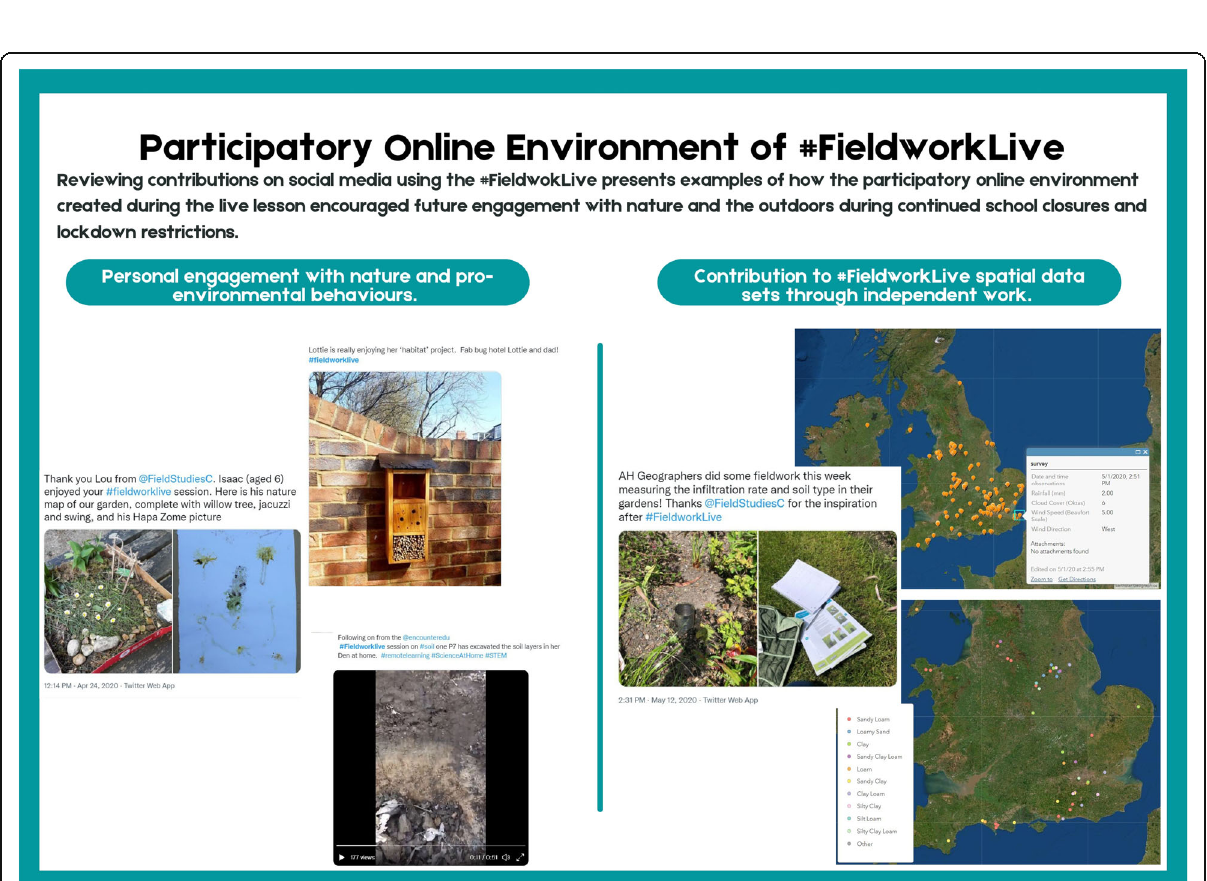
Fig. 4 Examples of the participatory online environment created by